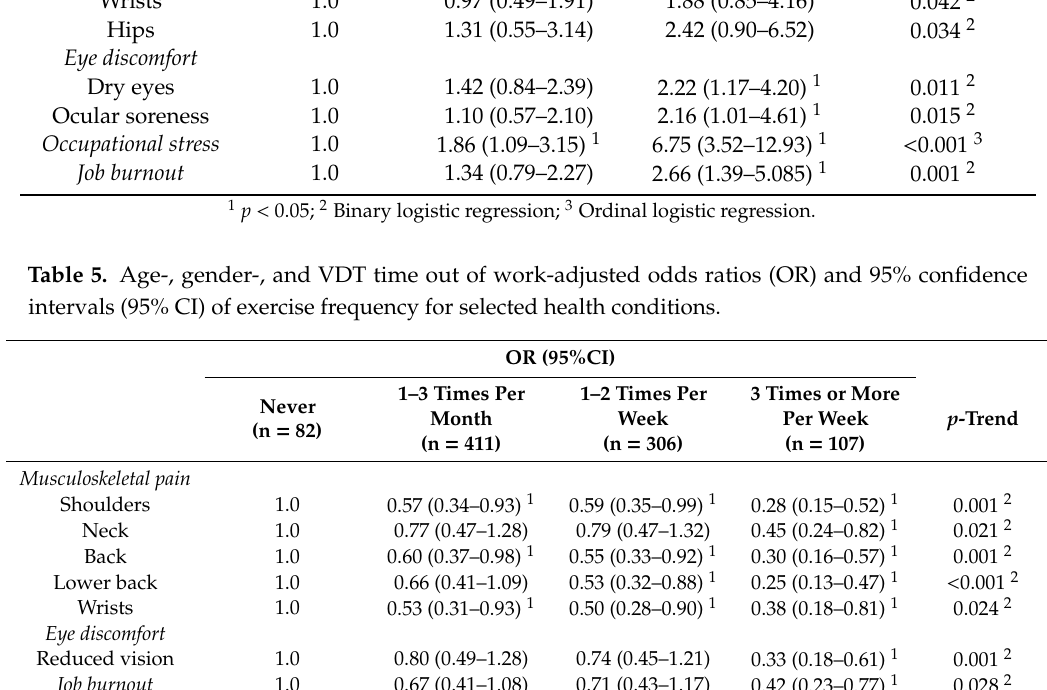
Table 4. Age-, gender-, and VDT time out of work-adjusted odds ratios (OR) and 95% confidence intervals (95% CI) of the duration of daily VDT use for selected health conditions. OR (95%CI) < 6h ( n = 70)